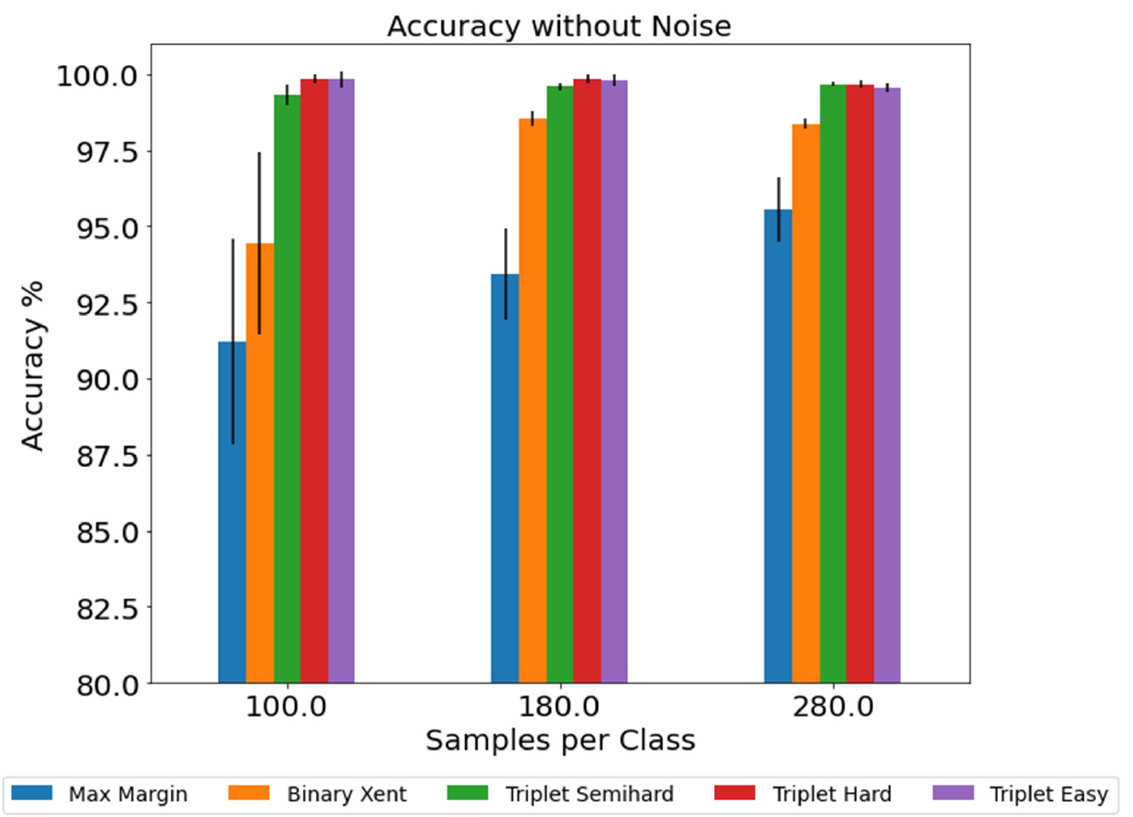
Figure 10. Accuracy of each model relative to the number of training and testing samples.